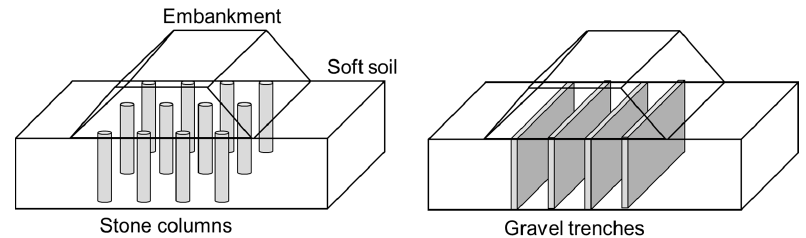
Figure 6. Longitudinal gravel trenches to model a stone column treatment in plane strain.